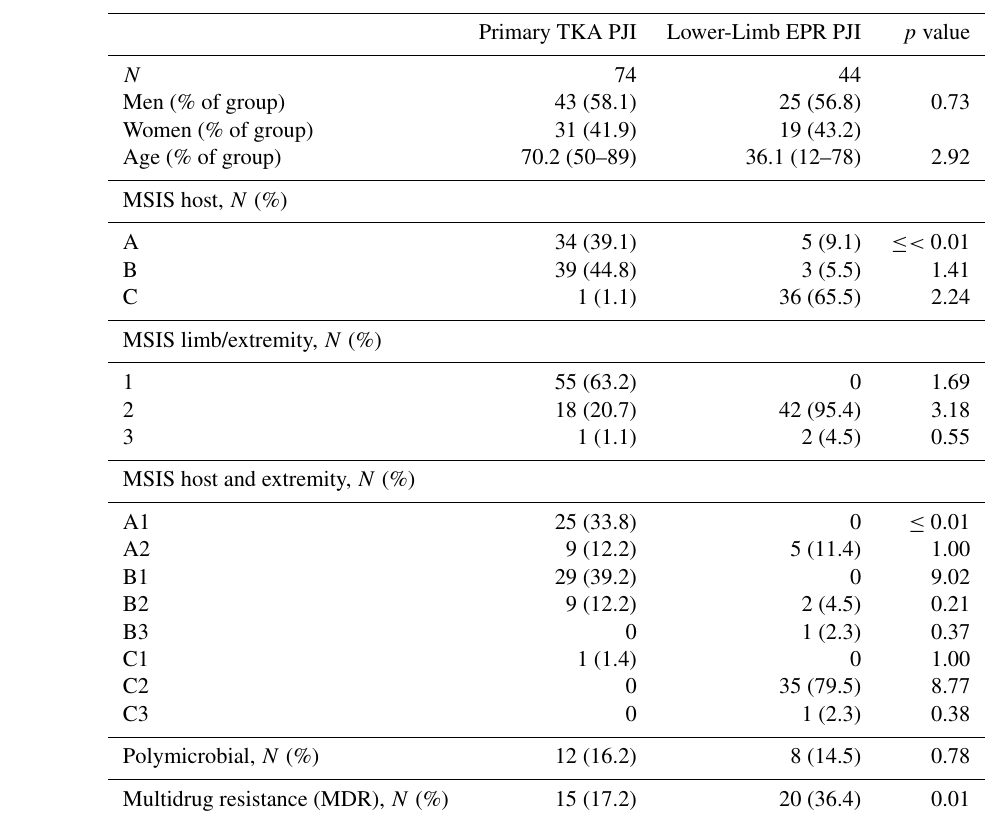
Table 1. Patient and limb status for both